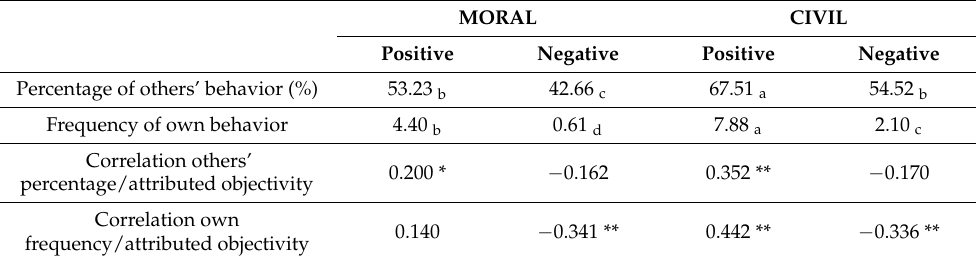
Table 3. Frequency of own and others’ behavior and correlation with attributed